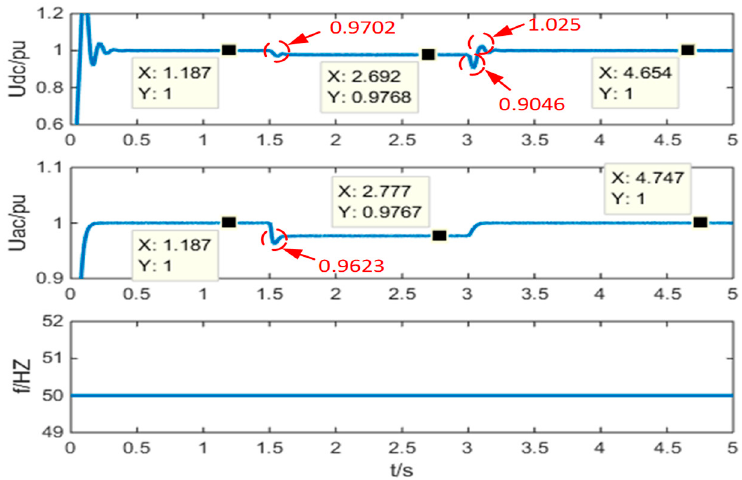
Figure 11. DC voltage, AC voltage, and frequency with traditional smooth transition control.